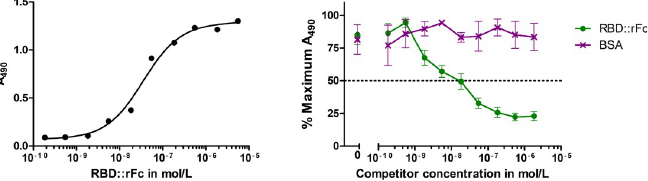
Fig 4. Characterization of algae-produced RBD::mClover through ACE2 receptor binding assays. (A) HEK-cell produced RBD fragment fused to Rabbit IgG Fc fragment (RBD::rFc) binding to immobilized biotinylated recombinant human ACE2 was detected by anti-Rabbit IgG-HRP antibodies and TMB chromogenic reaction. Data shown represent values from one experiment. (B) ACE2 Receptor binding competition assay between a constant concentration of partially purified ER-Golgi Retained Algae-Produced RBD::mClover (~40 nM) and increasing amounts of RBD::rFc or Bovine Serum Albumin showing specific competition. RBD::mClover binding was detected using anti-GFP HRP antibodies. Data points represent mean and error bars represent Standard Error of the Mean of normalized A 490 signal values over three independent experimental